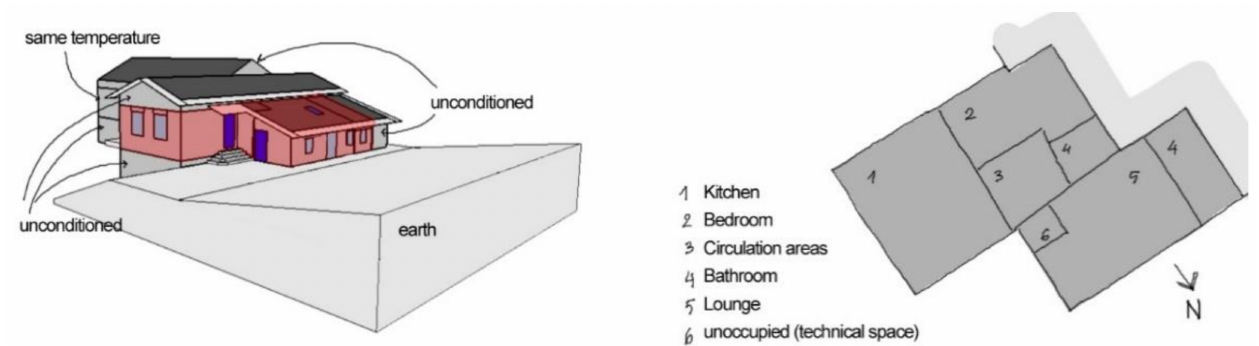
Figure 3. The initial model of the demo building developed using an EnergyPlus graphical